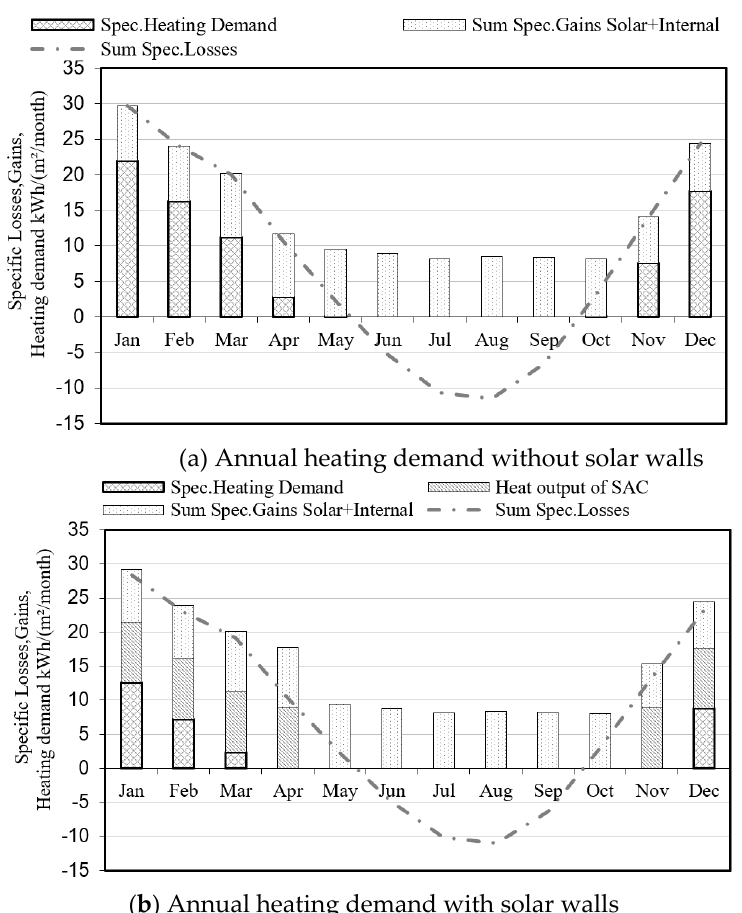
Figure 8. Annual heating demand under solar walls heating.